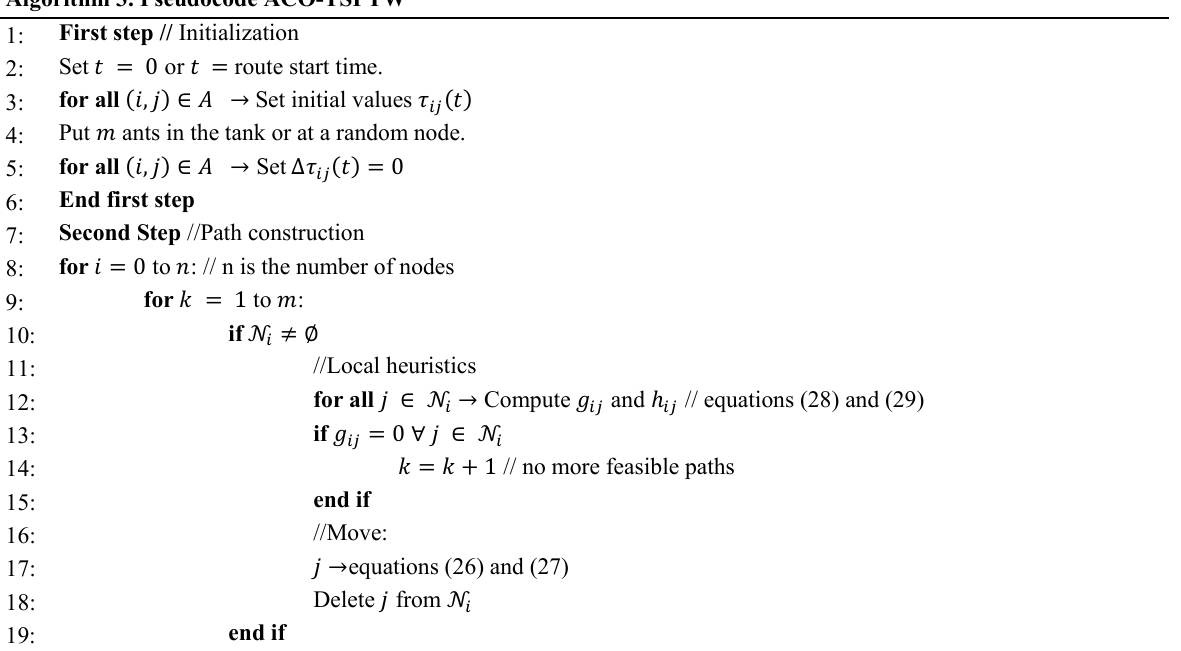
Algorithm 3. Pseudocode